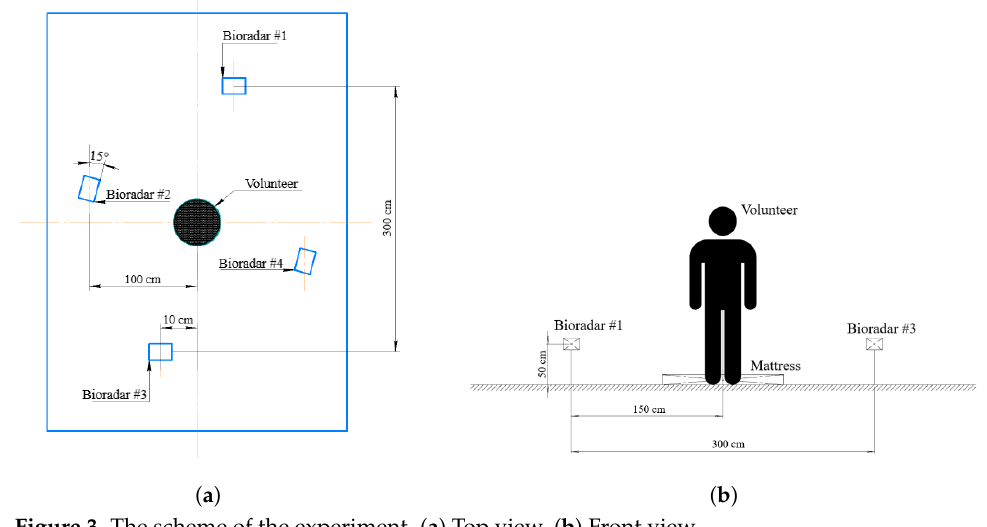
Figure 3. The scheme of the experiment. ( a ) Top view. ( b ) Front